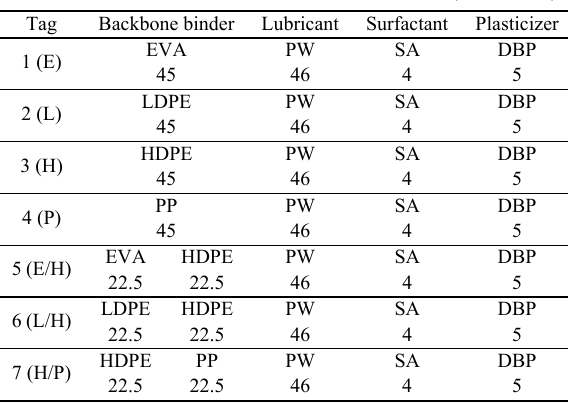
Table 1 Composition of the organic binders